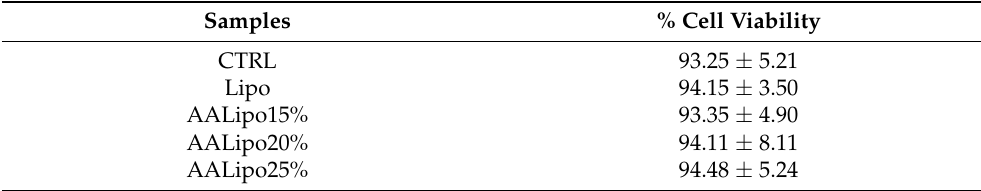
Table 3. Effect of different liposomal formulations on cell viability.